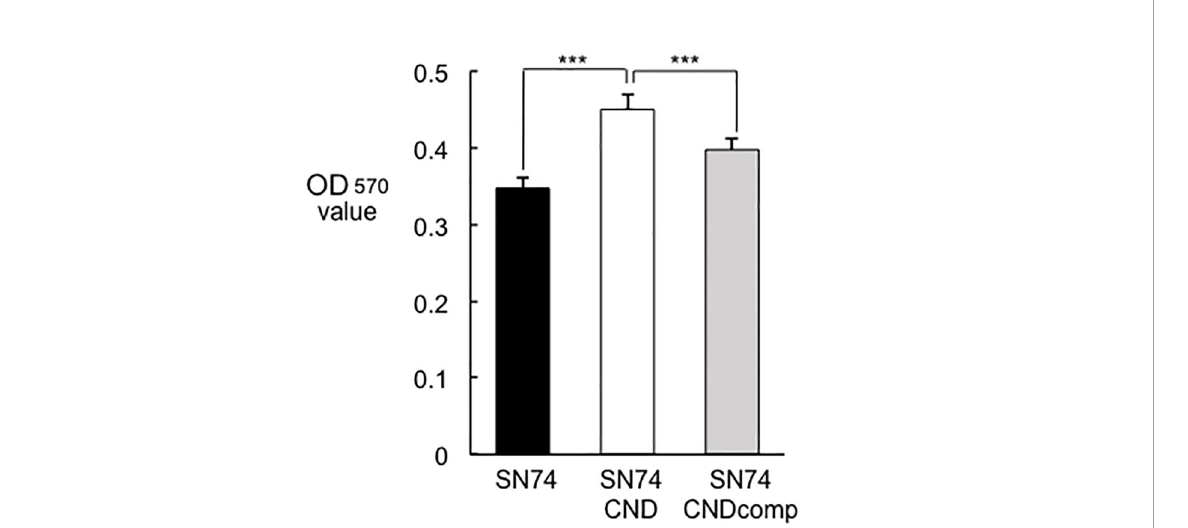
FIGURE 7 Amount of bio fi lm formation by strains SN74, SN74CND, and SN74CNDcomp. Bio fi lm formation by S. mutans strains SN74, SN74CND, and SN74CNDcomp cultured in 1.0% sucrose-added Todd Hewitt broth. The quantity of bio fi lm formation was determined from the OD570 value following crystal violet staining. Data are presented as the mean ± SD from fi ve independent experiments. Statistical signi fi cance was determined using analysis of variance with Bonferroni ’ s correction. *** P <